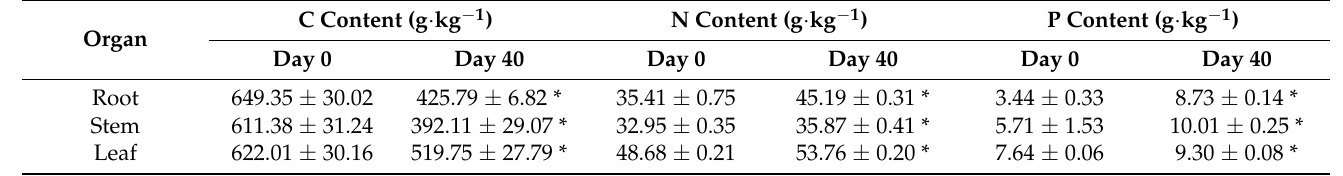
Table 1. Content of C, N, and P in various organs of water dropwort at different growth stages.